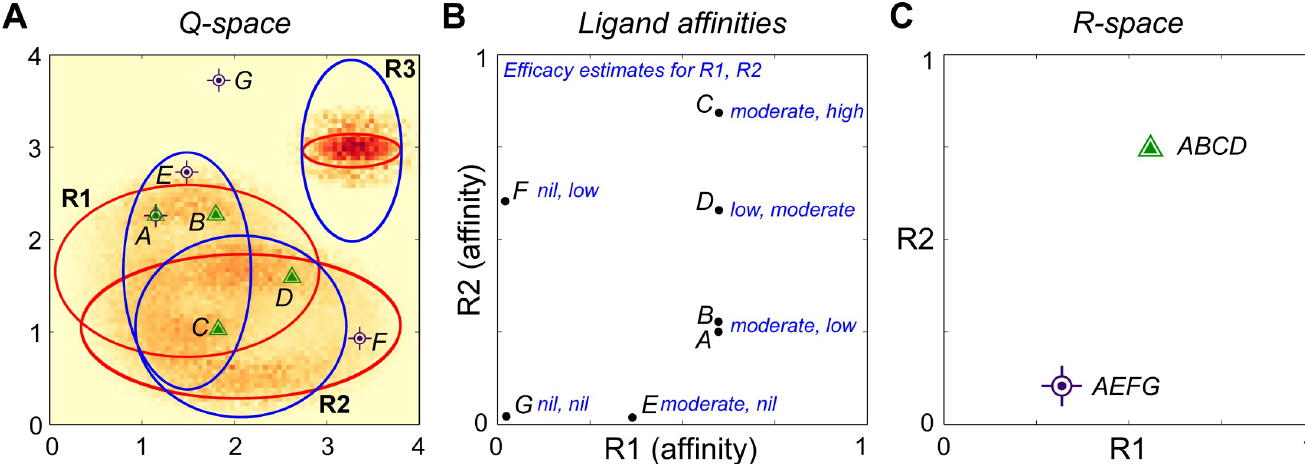
Fig 10. Illustration of physicochemical sampling and the transformation of odor representations from Q-space to R-space. A. A two-dimensional Q-space in which three receptors (Gaussian pairs R1, R2, R3) are deployed. Red ellipses denote the 1.5 σ contours of the affinity Gaussians, and blue those of the efficacy Gaussians, as in Fig 1. Two four-component source odors (i.e., comprising four ligand points) also are depicted: odor ABCD ( green triangles ) and odor AEFG ( violet bullseyes ; note that the two odors share one ligand in common). For present purposes, all ligands are presented at the same moderately effective concentration. As shorthand descriptors, affinity and efficacy are here described as high or strong when ligand points are near the center of the respective ellipse, moderate when just inside the ellipse contour, weak or low when just outside the contour, and nil when distant from the ellipse. Ligand A has moderate affinity for R1 and activates it with moderate efficacy, so constitutes a reasonably effective R1 agonist. It binds only weakly to R2, and with low efficacy. Ligand B binds to R1 with the same affinity and efficacy as ligand A, and interacts very weakly with R2 (though marginally less weakly than A). Ligand C also binds to R1 with the same moderate affinity and efficacy as ligands A-B, but binds strongly and with high efficacy to R2. Ligand D again has the same moderate affinity to R1, but exhibits a much lower efficacy; it is essentially an antagonist of R1. At R2, ligand D binds moderately well and is an agonist of moderate efficacy. Ligand E binds more weakly to R1 than ligands A-D, but exhibits the same efficacy there as ligands A-C. It does not appreciably interact with R2. Ligand F does not interact appreciably with R1, but exhibits moderate binding and low efficacy to R2 –i.e., it is a partial agonist of R2 tending towards antagonism. Ligand G does not interact measurably with either R1 or R2 –that is, this particular complement of receptors is insensitive to ligand G. (Of course, a different animal species might express a receptor that interacts substantially with ligand G). None of the ligands interact measurably with receptor R3. The color of the heat map (see Fig 1F for scale) denotes a d � C � value for that ligand point–the expected contribution of that ligand (across all receptors) to the overall discrimination capacity. As the ligands of odor ABCD, combined, exhibit a greater sum of individual d � C � values than those of odor AEFG, it will be easier for the animal expressing these receptors to detect a small quality change to ABCD than it would to detect a similar quality change to AEFG. B. Plot of the affinities of each ligand for receptors R1 and R2, where 0 denotes no affinity and 1 denotes the strongest affinity (K d = 10 − 8 M in most of the present simulations). Receptor R3 is neglected as it interacts with no ligands. Each plotted point also is labelled with that ligand’s efficacy at R1 and R2 (respectively). C. Depiction of the two source odors in the R-space defined by receptors R1 and R2 (R3 is again neglected). Odor ABCD ( green triangle ) activates R1 moderately, assuming that the three moderate agonists outweigh the effects of the single moderate antagonist, and activates R2 moderately strongly, because ligands C and D are both effective agonists whereas ligands A and B do not strongly interact with that receptor. Odor AEFG ( violet bullseye ) activates R1 relatively weakly, because A is a moderate agonist, E is a weak agonist, and F and G do not appreciably interact with the receptor. Among the ligands of odor AEFG, only ligand F interacts substantially with R2, as a low-efficacy partial agonist–consequently, R2 is minimally activated by that odor. The distance between these two odor representations in R-space denotes their physical similarity after sampling. Importantly, if these same two odors were sampled by an animal expressing two different receptors, this similarity relationship would be different. Moreover, the full representation of odors ABCD and AEFG in R-space does not actually comprise a single point, but a smooth manifold, based on experience and incorporating the natural quality variance of the odor source (discussed in [78]).